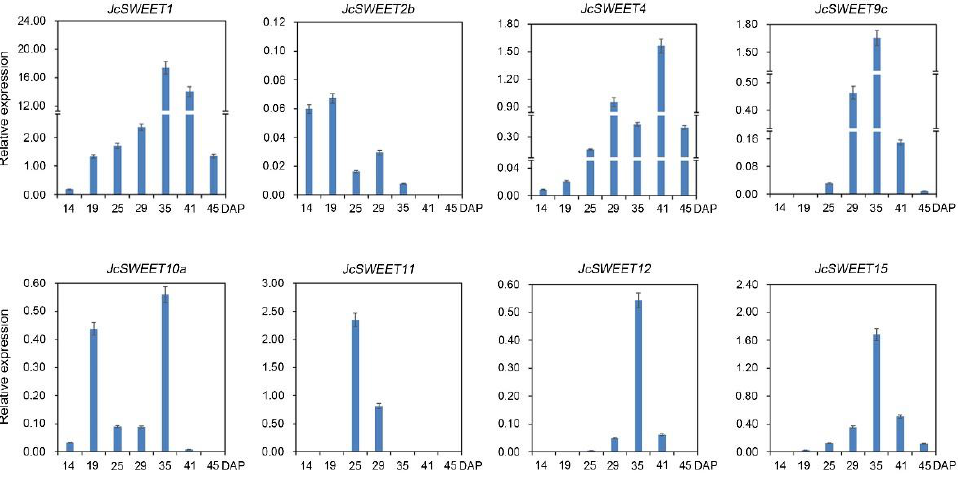
Figure 4. Patterns of expression of JcSWEET genes of seeds from 14 to 45 days after pollination (DAP). The relative expression was normalized to that of the reference gene JcActin (internal con- trol).